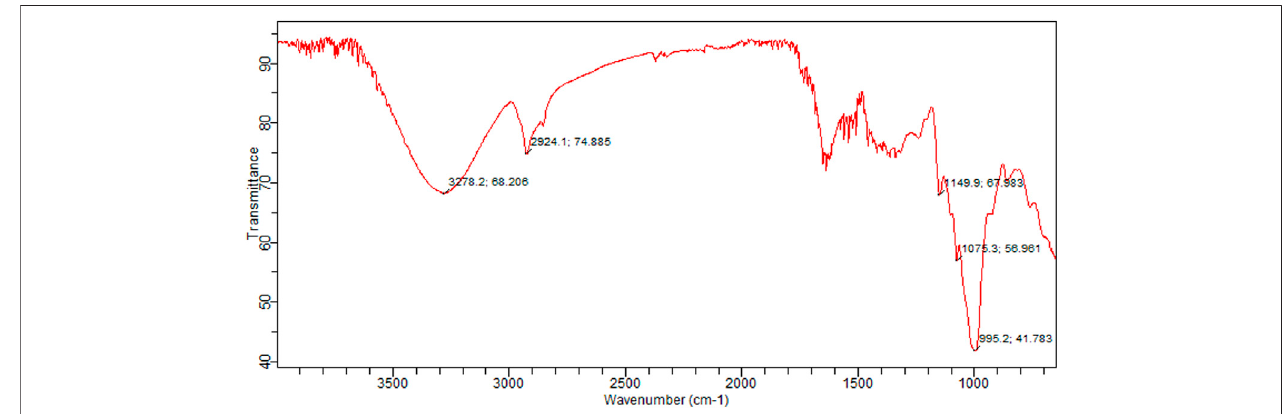
FIGURE 5 | FTIR spectra of N . sativa seed powder.